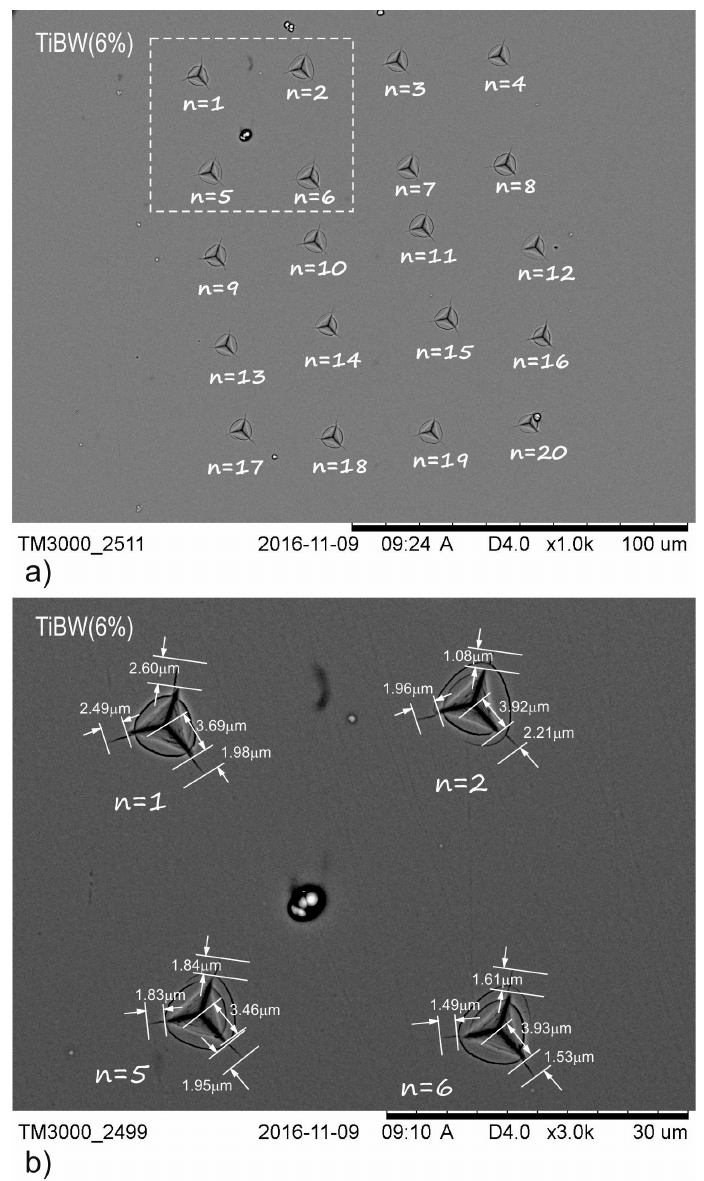
Figure 4. SEM images of groups indentations used for TiBW (6%) of fracture toughness analysis: ( a ) series of 20 indentations at a load of P critical = 200 mN; ( b ) representation of crack lengths for different indentations where n = 1, 2, 5, 6 [20].